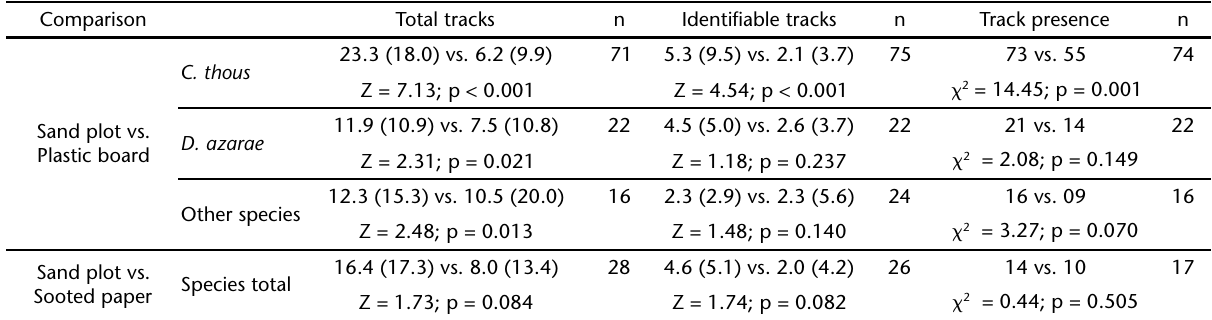
Table II. Mean (SD) total and identifiable tracks obtained in sand plots and artificial plots (plastic board or sooted paper) placed in the Pantanal region, Brazil over 2002-2005. Track presence was the total number of records (number of species per track station-night) obtained on each type of tracking trap. Total number of tracks and number of identifiable tracks were compared using Wilcoxon matched pair test; track presence was compared between pairs of tracking traps using McNemar test. Whenever possible, data on C. thous and D. azarae were analyzed separately from other species listed in Table I. n = sample